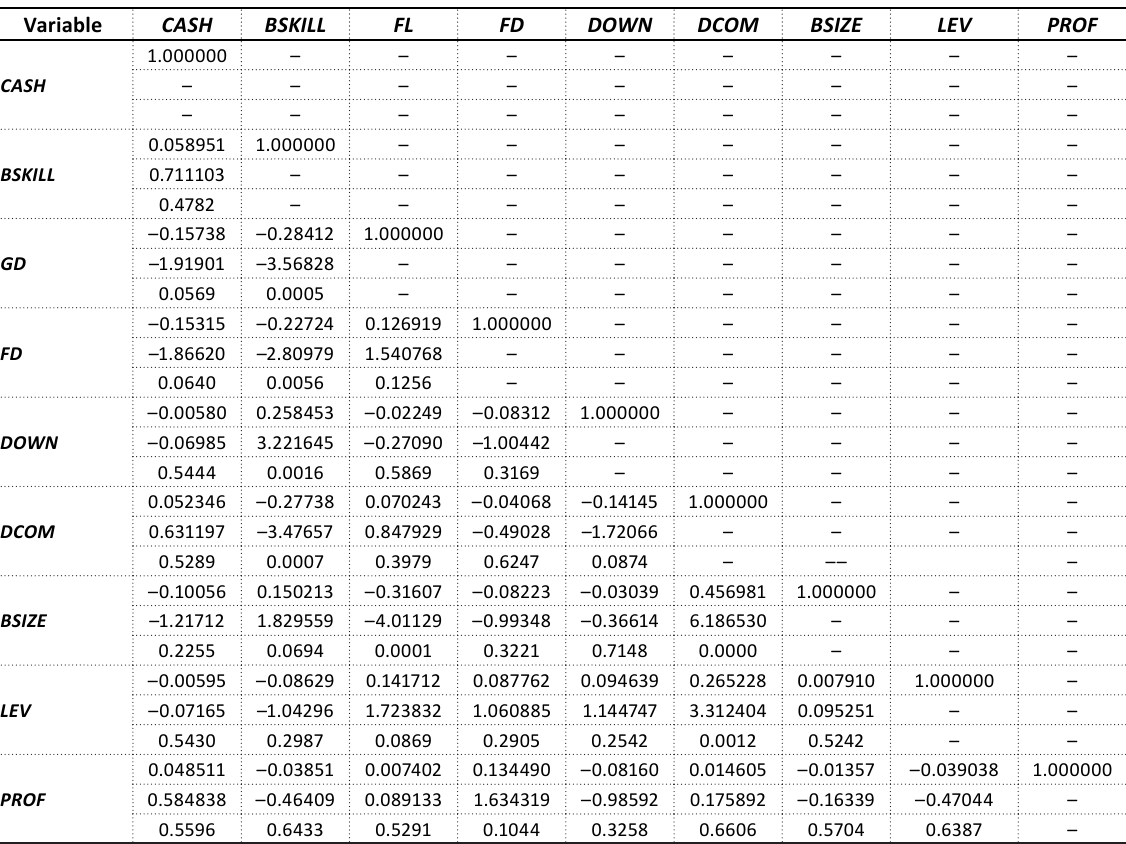
Table 3. Correlation